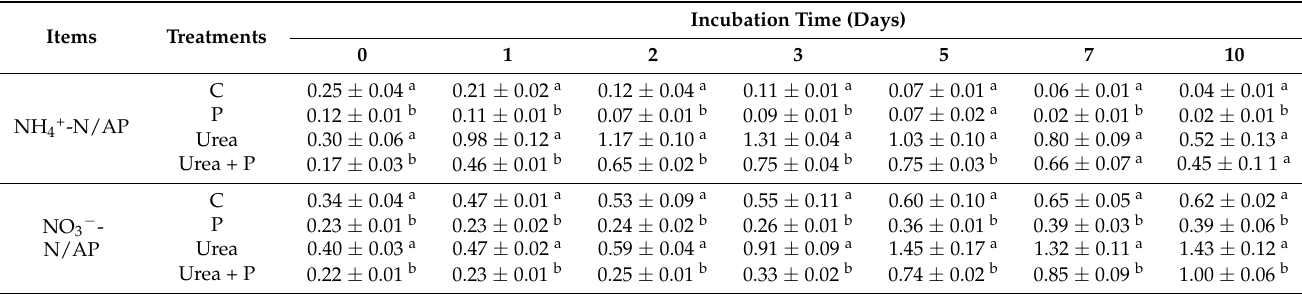
Table 3. Changes in the labile N:P ratio in soils during the incubation study.